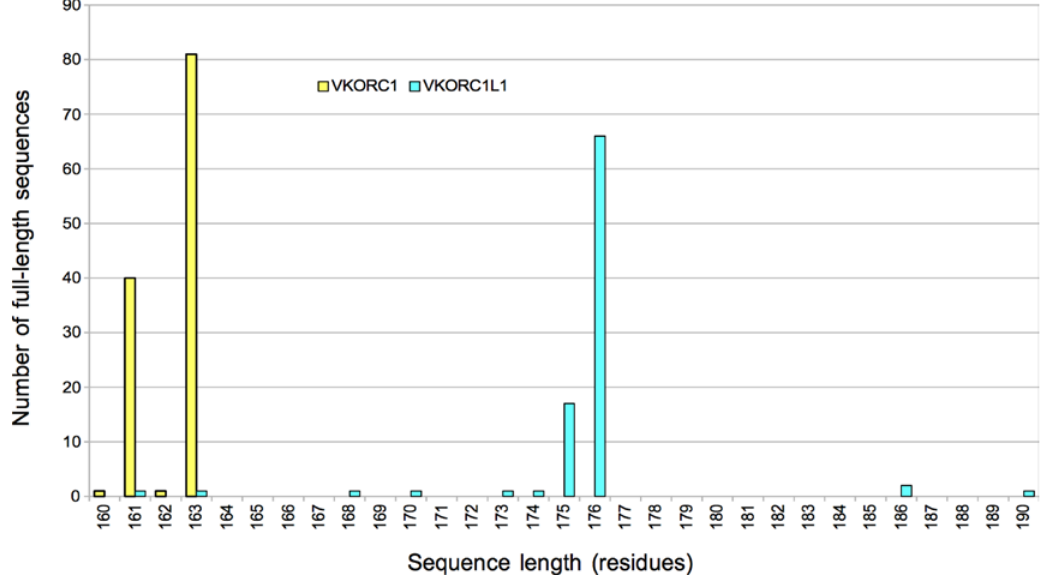
Figure 3. Histogram of vertebrate VKOR paralog sequence lengths in the NCBI Protein database. All sequences included were verified as full-length isoform 1 for VKORC1 (yellow bars) and VKORC1L1 (cyan bars).